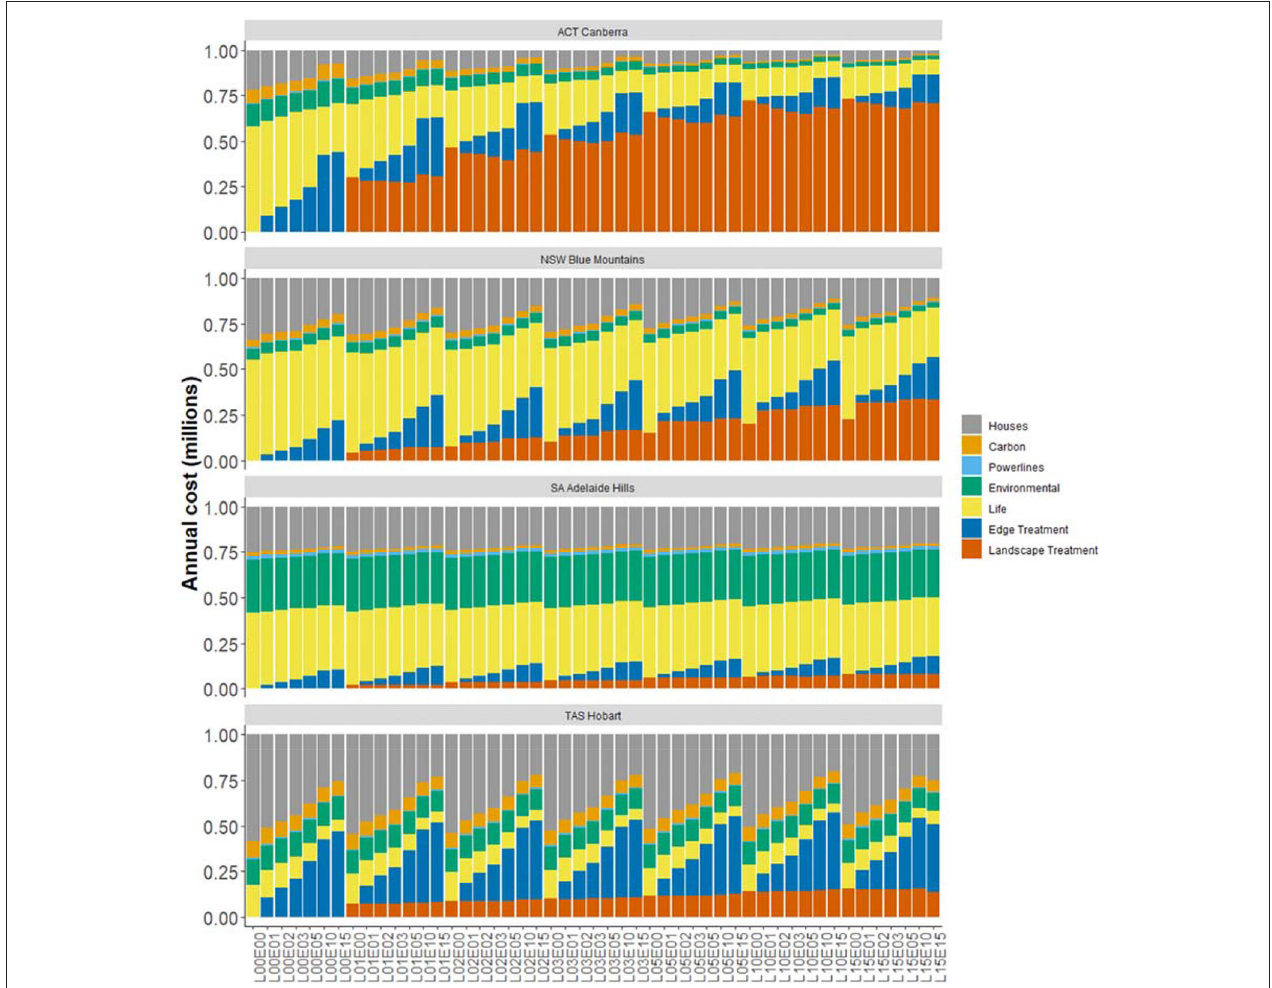
FIGURE 6 | Relative contribution of treatments and asset risk costs for four case study regions across all treatment rates. Treatment codes are presented as LXXEYY where XX represents the annual prescribed burning treatment rate in the landscape and YY the rate in the edge blocks.